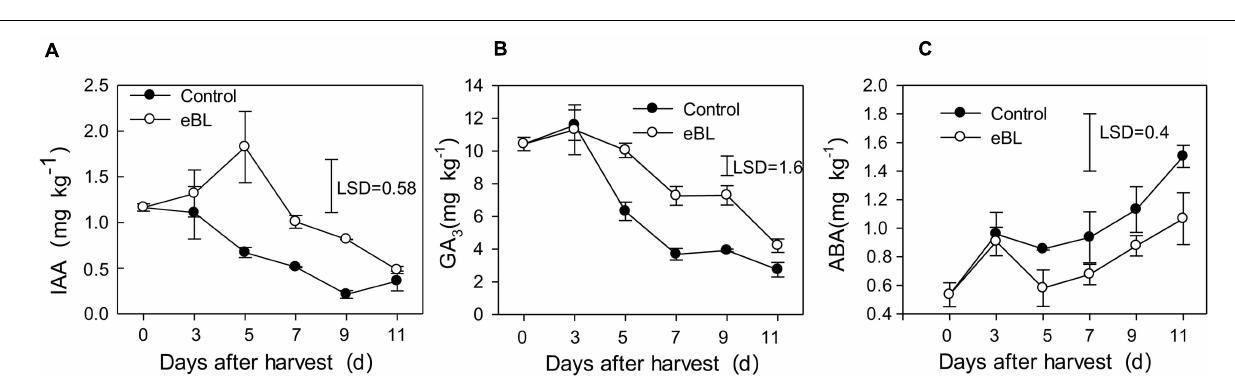
FIGURE 6 | Effects of eBL treatment on the content of endogenous hormones. (A) IAA; (B) GA3; (C) ABA. Least significant differences (LSDs) were calculated to compare significant effects at the 5% level. Each data point represents the mean ± S.E. ( n =